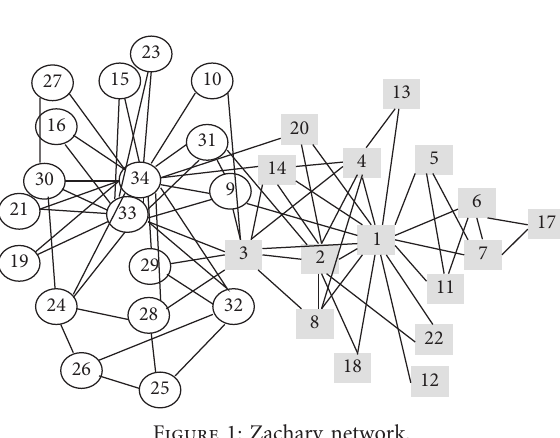
Figure 1: Zachary